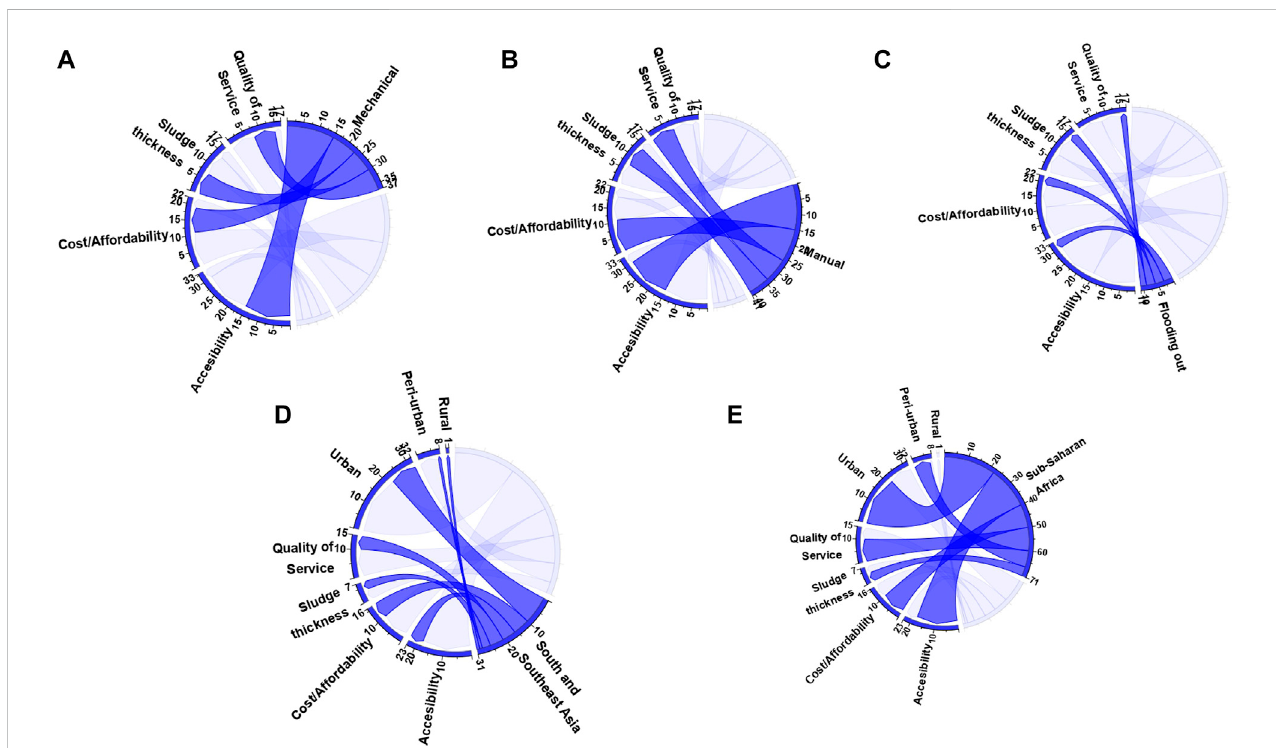
FIGURE 4 Factors in fl uencing selection of emptying methods (A) Manual emptying method (B) Mechanical emptying method (C) Flooding out (D) Sub-Saharan Africa (E) South and Southeast